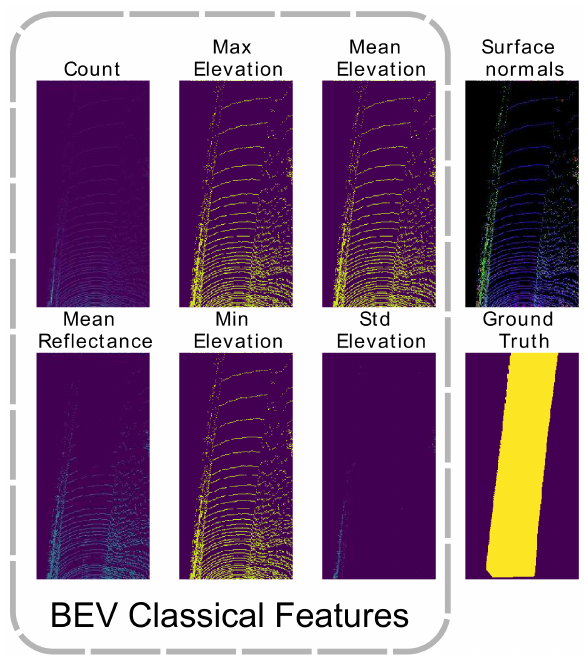
Figure 6. An example of features projected on the BEV in case of a 64 layers scanner. Surface normals are computed on SV and projected to BEV.